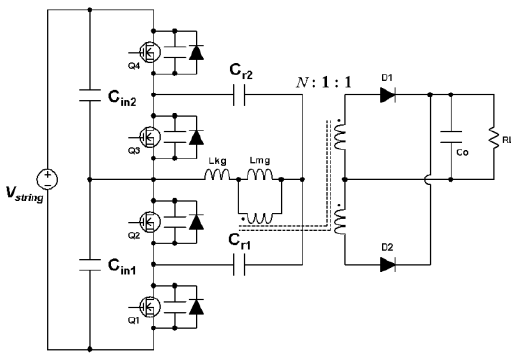
Figure 3. Three-level LLC resonant converter.